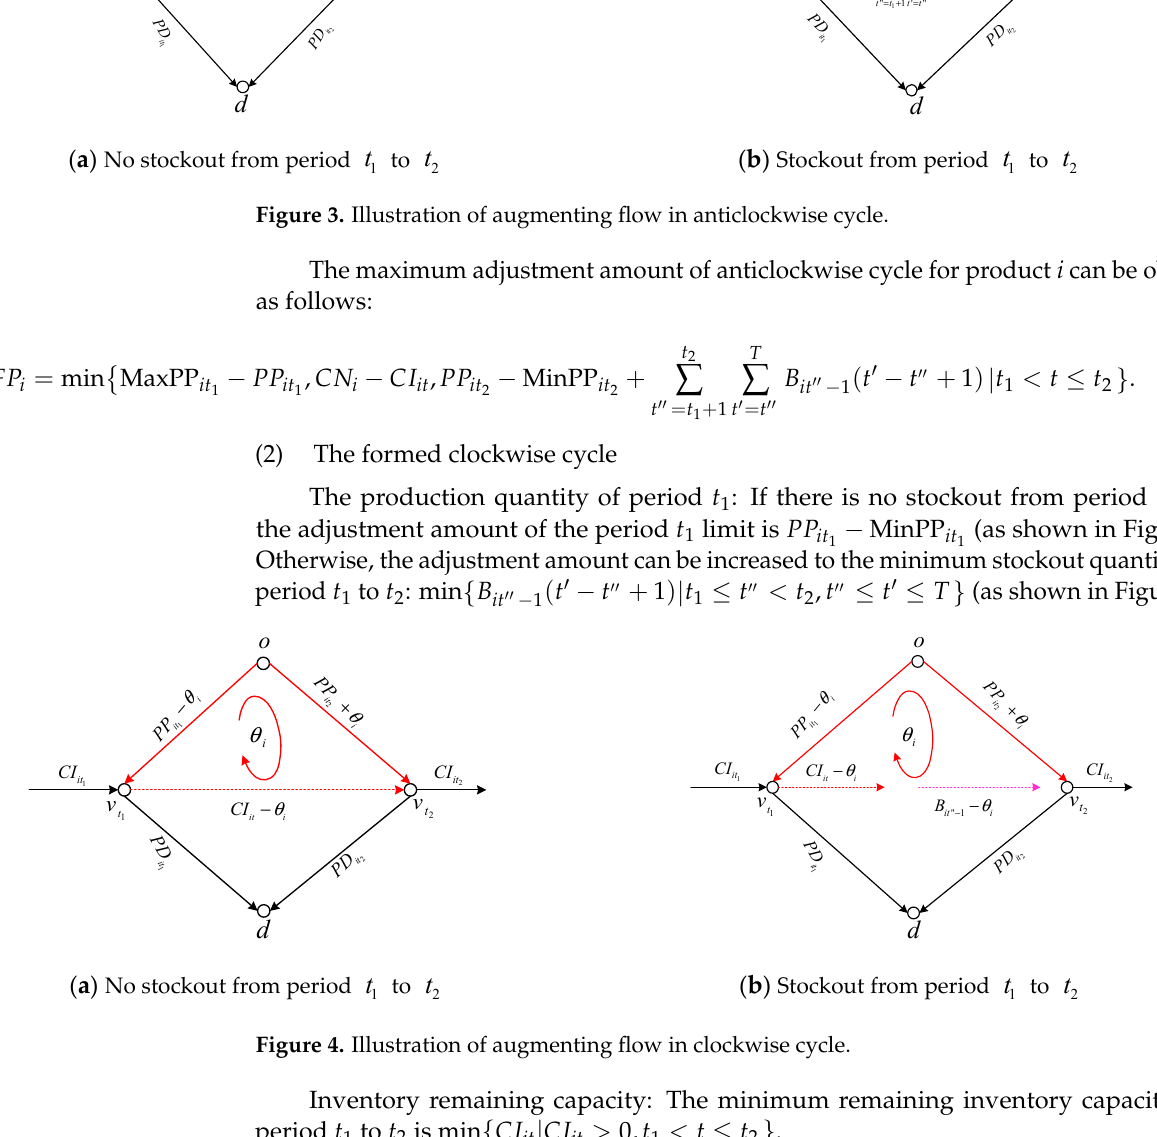
Figure 4. Illustration of augmenting flow in clockwise cycle.